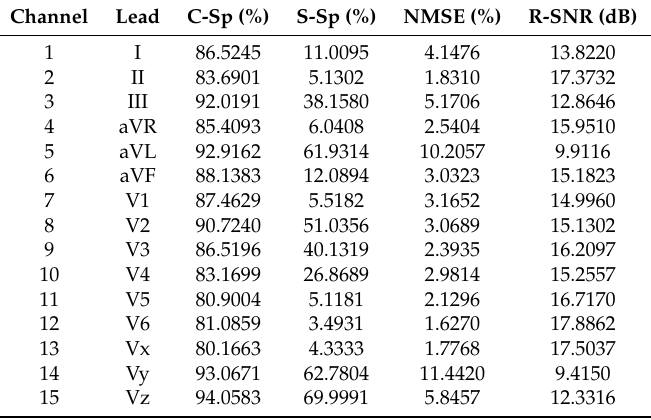
Table 1. Performance of the constructed dictionary (using waveforms extracted from lead V4) on other leads from Patient 104 not used to construct the